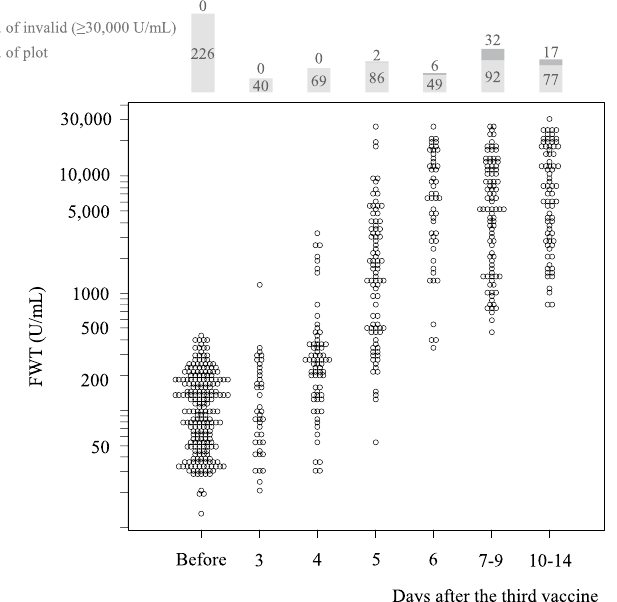
Figure 2. Early-stage antibody kinetics post-third dose of the vaccine. Antibody titers measured using FWT are shown. The numbers of plotted and invalid samples are shown in the upper part of the graph. Kruskal–Wallis test and Mann–Whitney U test with Bonferroni correction was applied among antibody titers of pre- and post-booster day 3, 4, 5, and 6. Antibody titers of pre- and post-booster day 3 were not significantly different ( p = 1.00). The difference between pre- and post-booster antibody titers was significantly different from day 4 and thereafter.